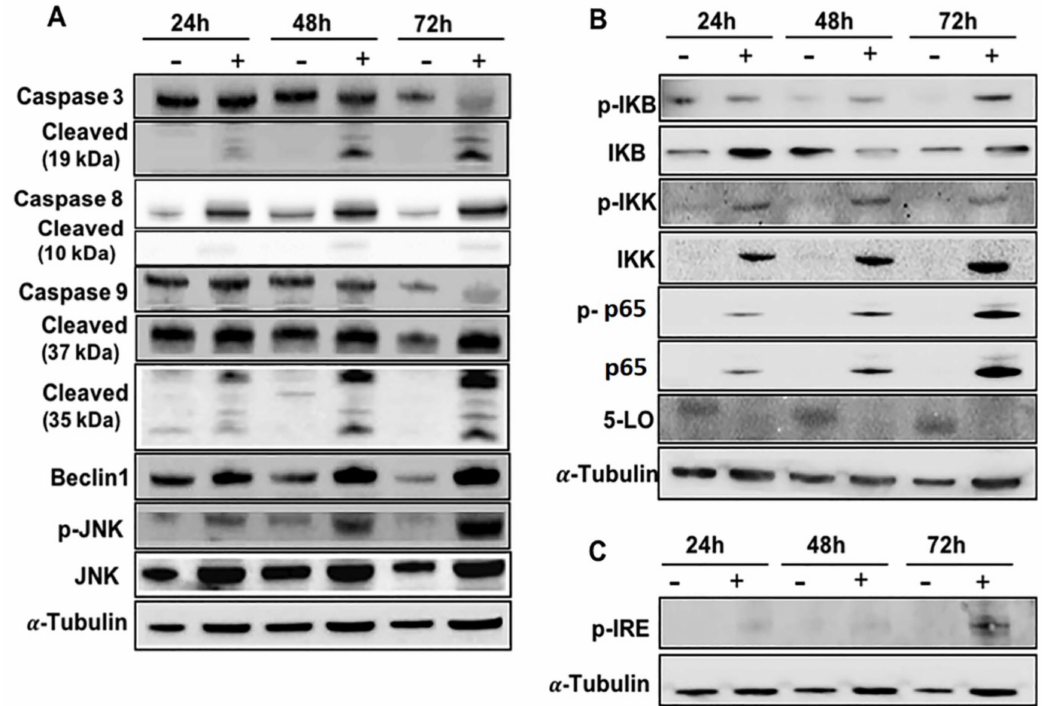
Figure 6. E ff ects of EA-100C red on signal transduction pathways. LN229 cells were treated for 72 h with IC 50 of EA-100C red. Cell lysates were incubated with anti-human antibodies and analysed by western blotting; the housekeeping protein α -tubulin was used as loading control. EA-100C red was able to induce already after 24 h the activation of caspases 3 ( A ), 8 ( A ) p65 and 9( A ), p-JNK( A ), p-IKK ( B ), p-IKB ( B ), p-p65 ( B ), p-IRE ( C ), the increase of Beclin -1( A ) expression and the inhibition of 5-LO expression ( B